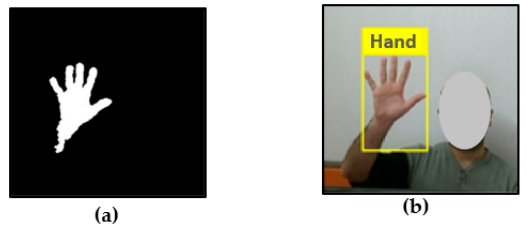
Figure 6. Example of skin color detection. ( a ) Apply threshold to the channels of YUV color space in order to extract only skin color then assign 1 value for the skin and 0 to non-skin color; ( b ) detected and tracked hand using resulted binary image.